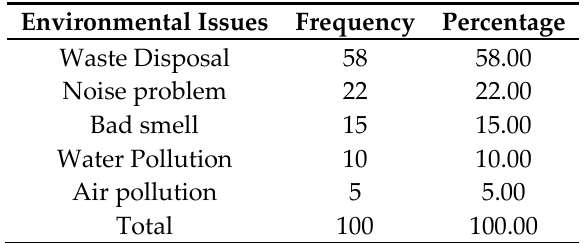
Table 1. Frequency of important environment issues in SSRU.